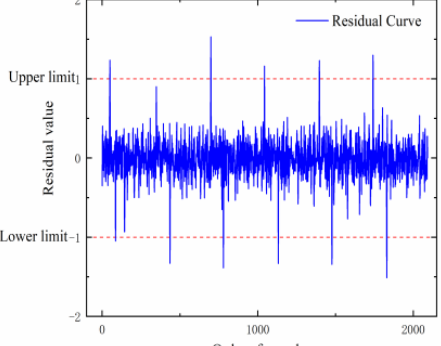
Figure 12. Normal operating condition residual value curve. Table 8. Statistical Table of Residual Values under Normal Working Conditions.